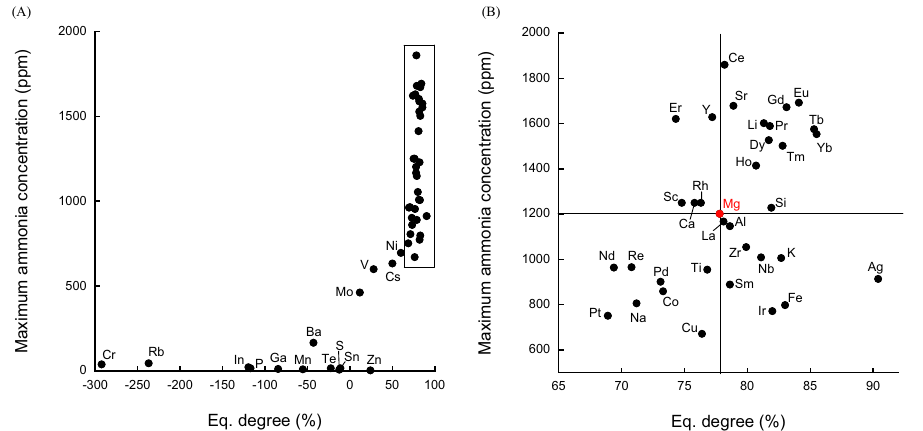
Figure 5. Correlation between maximum ammonia concentration and equilibrium achievement degree. ( A ) All catalysts. ( B ) Enlarged view of the enclosed area in panel ( A ). The elemental symbols correspond to the added elements.